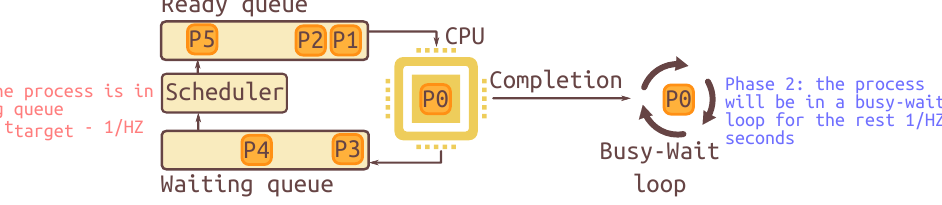
Figure 2. Simplified scheme of executing processes with